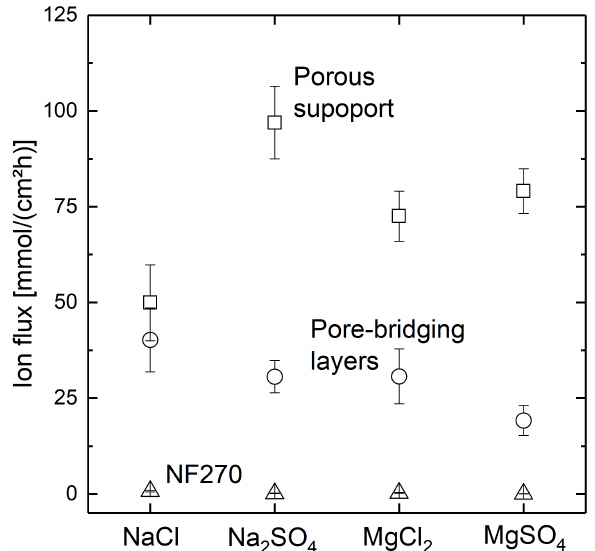
Figure 10. Ion Flux of NaCl, Na 2 SO 4 , MgCl 2 , and MgSO 4 across a porous support structure with three bilayers of PDADMAC/PSS coated with a fully water-wetted support, a porous support structure coated with three bilayers of PDADMAC/PSS with air-filled pores during coating, and a commercial NF270 nanofiltration membrane for reference. Experiments were performed with three membranes